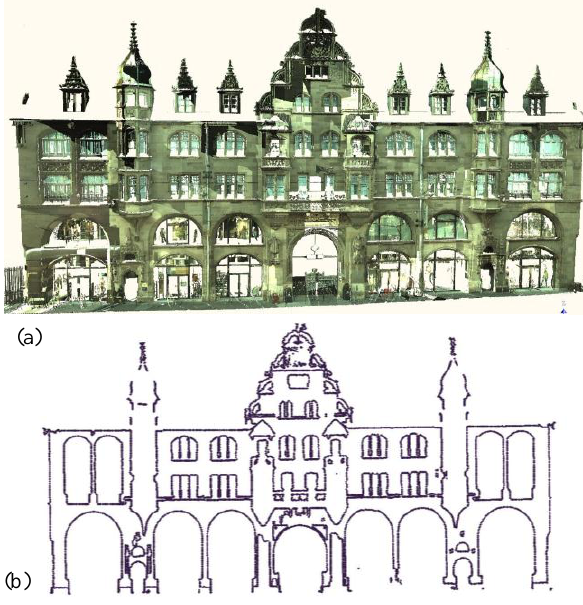
Figure 3. Scanned façade of a complex architectural building (a) and extracted contours (b) After segmentation in planes, the contour points of the main façade plane have been extracted (Figure 3b) and adjusted in order to produce a vector model of the façade. A few polygons from the restituted model have been chosen for the contours evaluation (Figure 4).